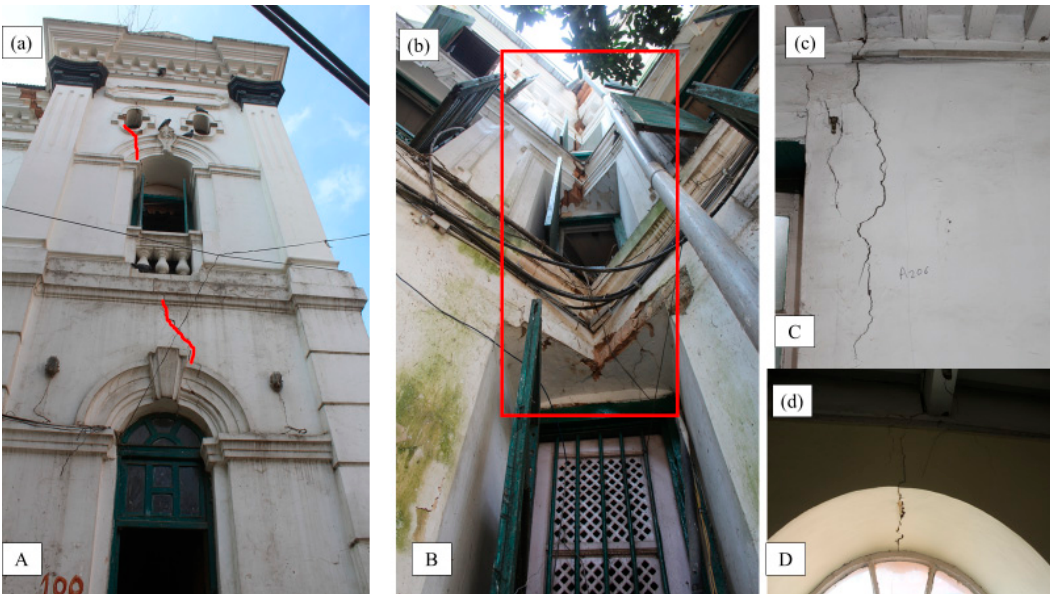
Figure 3. Local damages in the monument ( a ) damage above the crown of arches, ( b ) corner damage at the junction of north and west lounge, ( c ) vertical crack, ( d ) crown damage (uppercase indications at the bottom of the structures are the location indications as shown in Figure 2).